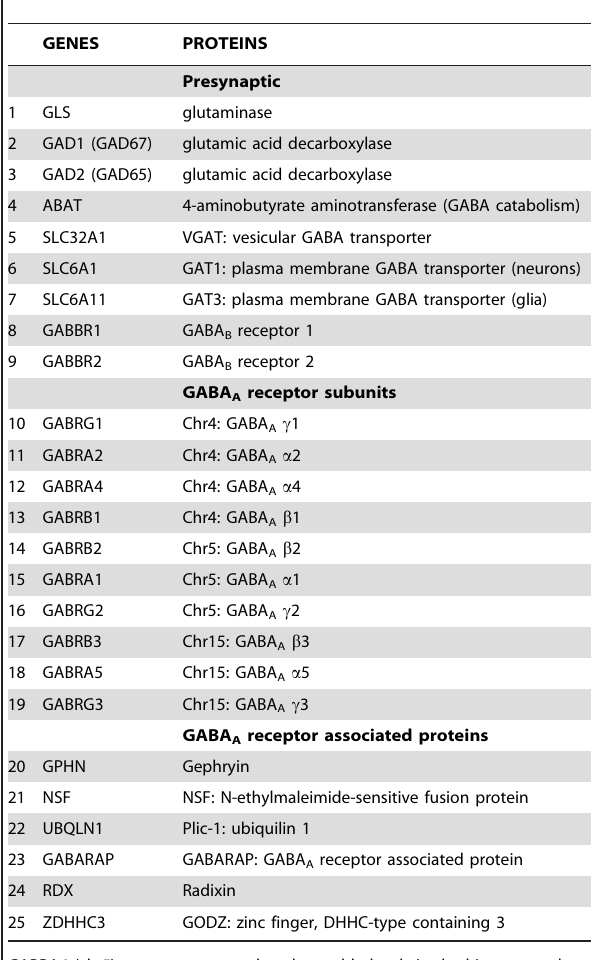
Table 1. GABAergic Pathway Candidate